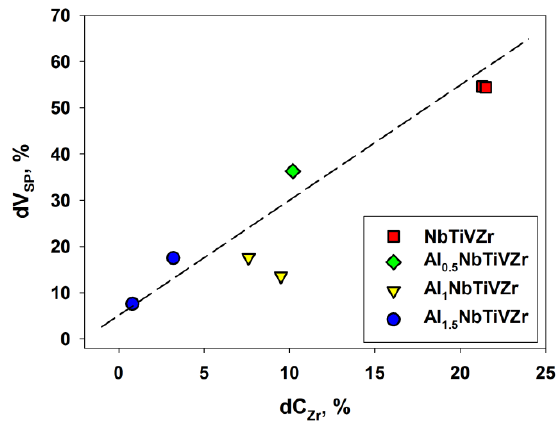
Figure 8. The dependence between the increase of second phase volume fraction (d V SP ) and the decrease of the Zr content in the bcc solid solution phase due to intermediate temperature (800 °C and 1000 °C) annealing (d C Zr ) in the Al x NbTiVZr ( x = 0; 0.5; 1; 1.5) alloys.